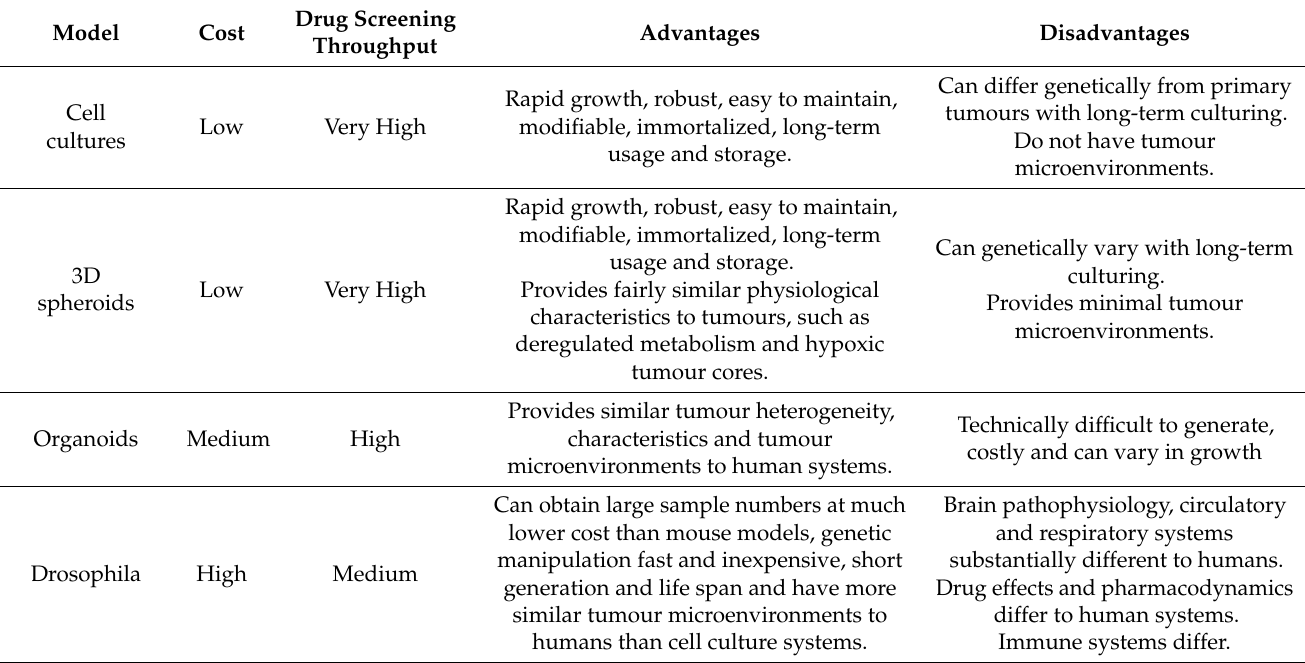
Table 3. Comparison between zebrafish and other paediatric brain cancer